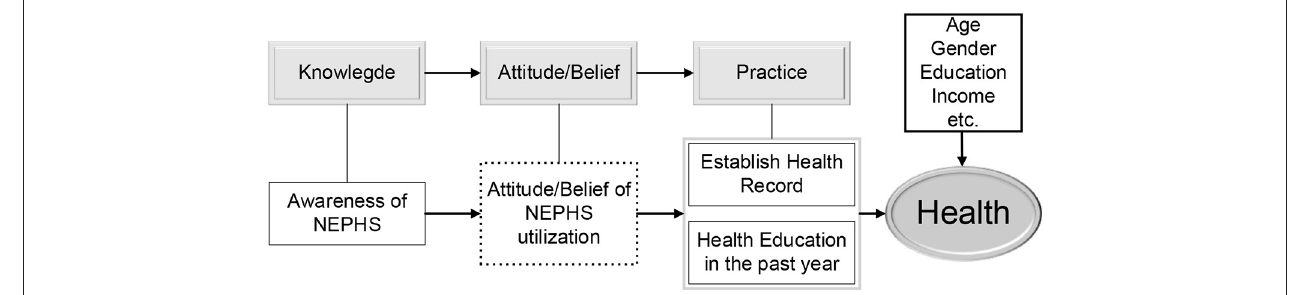
FIGURE 1 | Conceptual